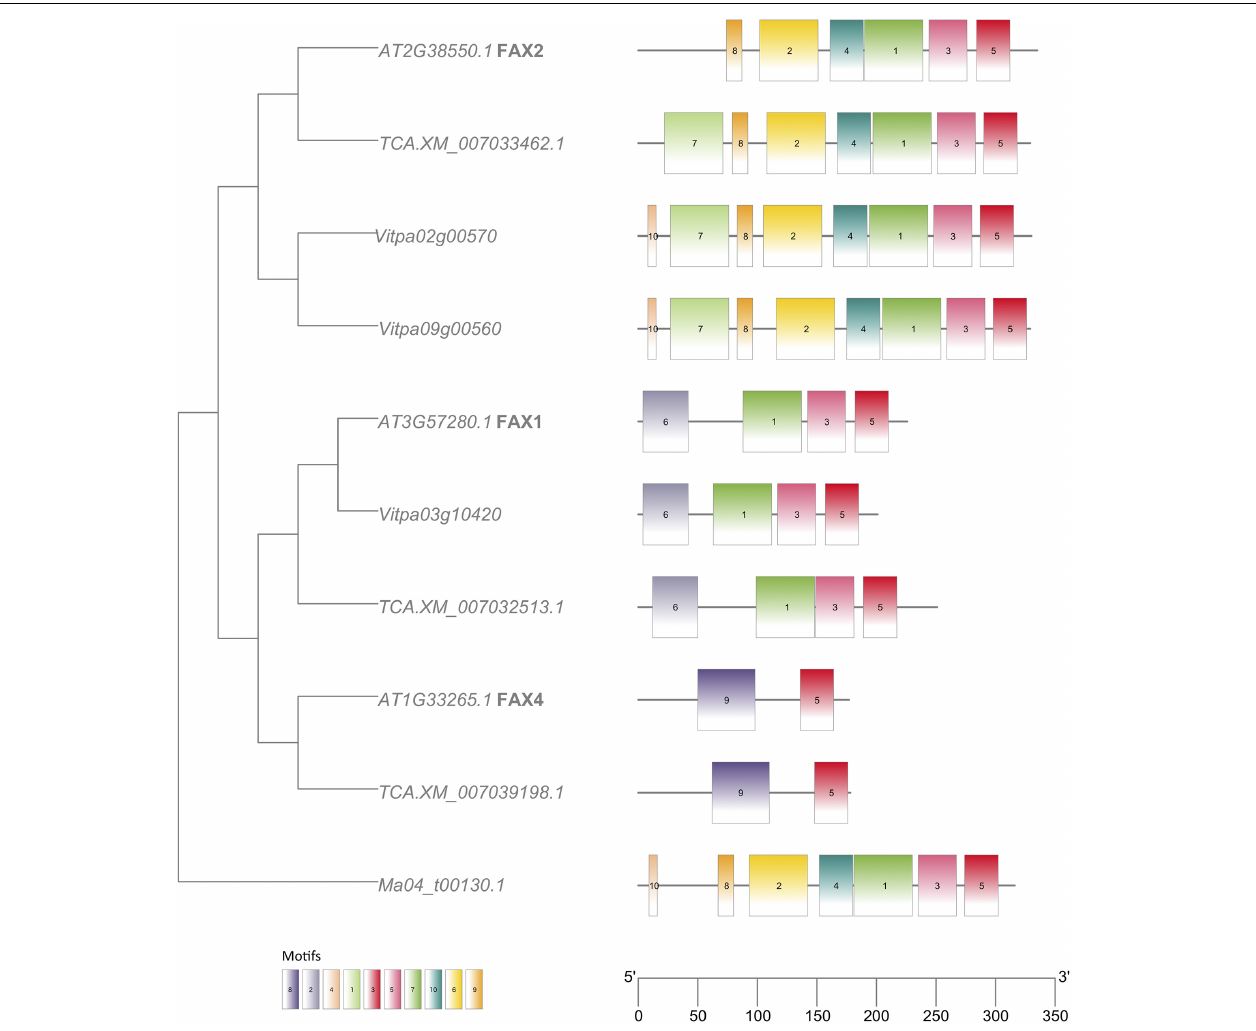
FIGURE 7 | FAX (Fatty acid exporter) gene tree with MEME motifs, comparing orthologs from Arabidopsis thaliana (“AT ... ”), Theobroma cacao (“TCA.XM ... ”) and Vitellaria paradoxa (“Vitpa ... ”). An ortholog from Musa acuminata (“Ma ... ”) of clade Monocots serves as outgroup. Trees for the other FA biosynthesis